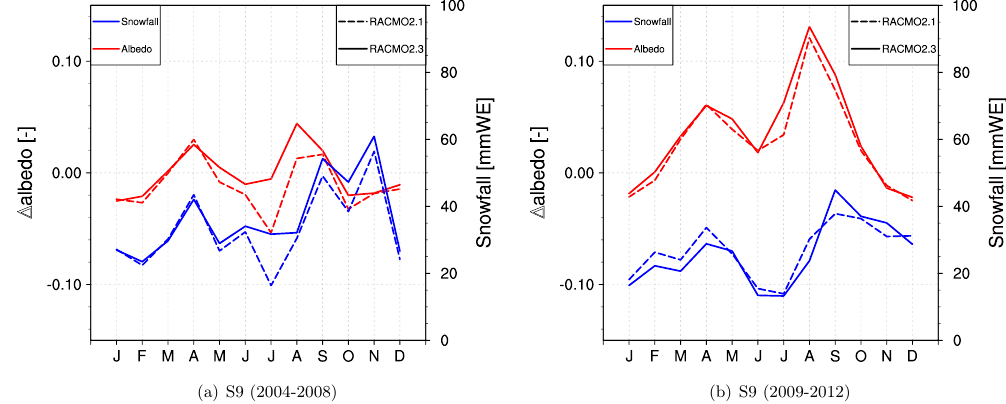
Figure 6. Differences in monthly mean surface albedo between models and S9 measurements, and monthly mean modelled snowfall for the periods (a) 2004–2008 and (b)